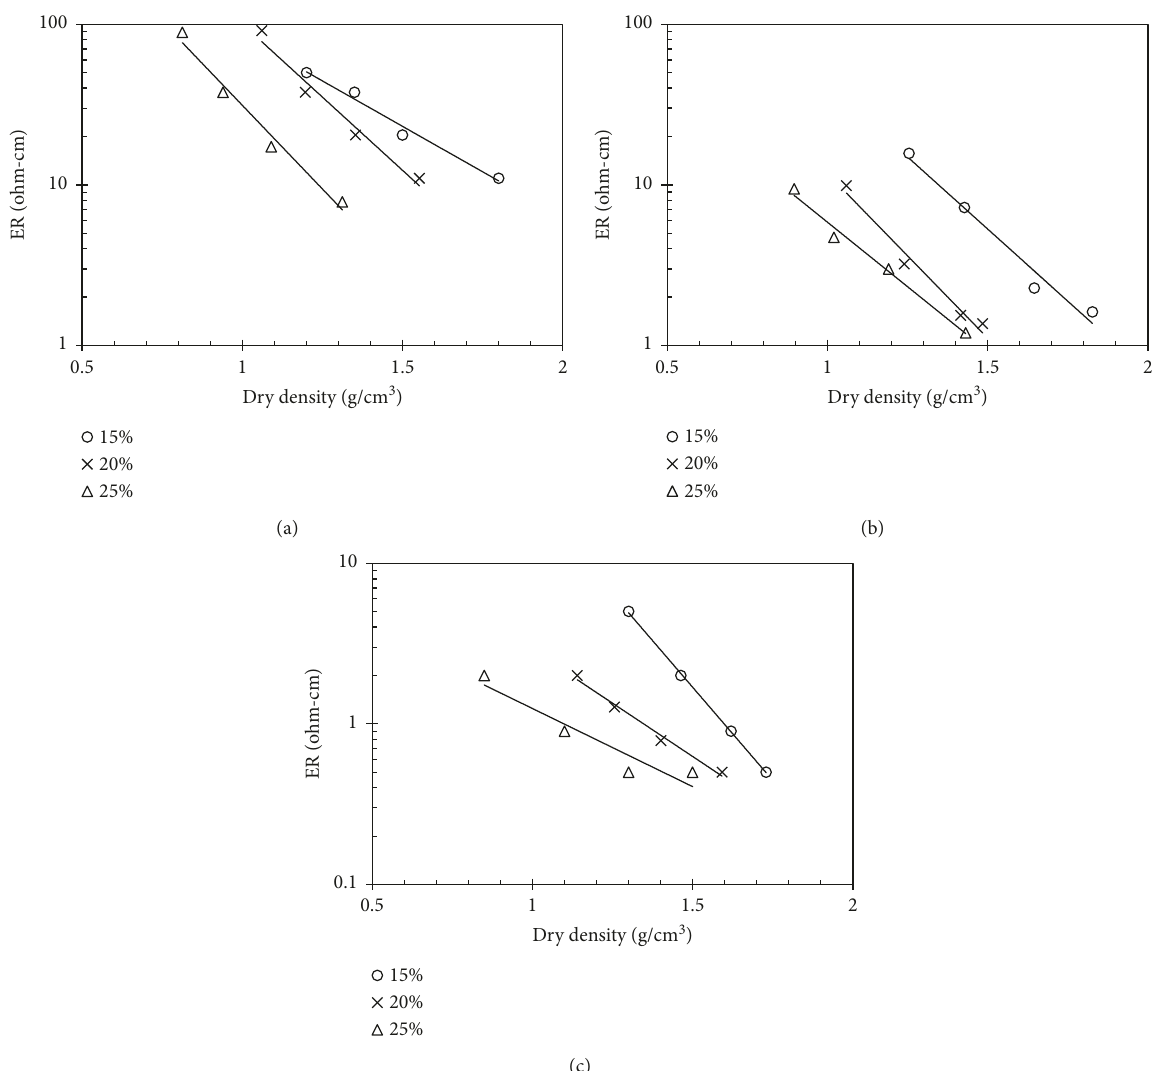
Figure 7: ER for k10 in (a) 0M, (b) 0.5M, and (c) 1M NaCl solutions at 15%, 20%, and 25% water